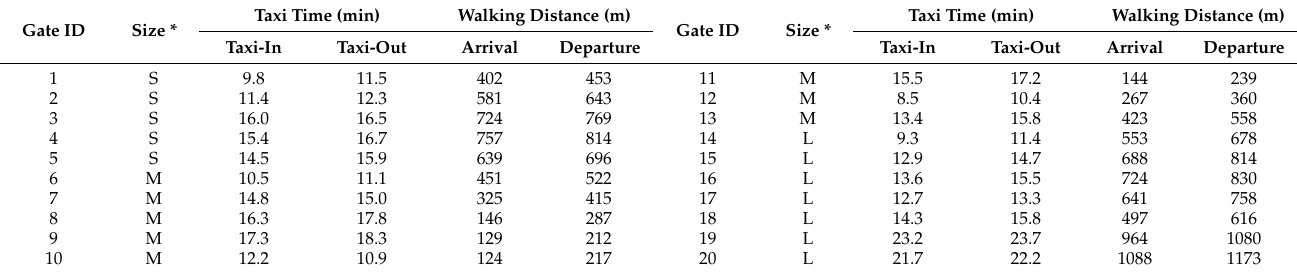
Table 2. Basic information of gate resources.